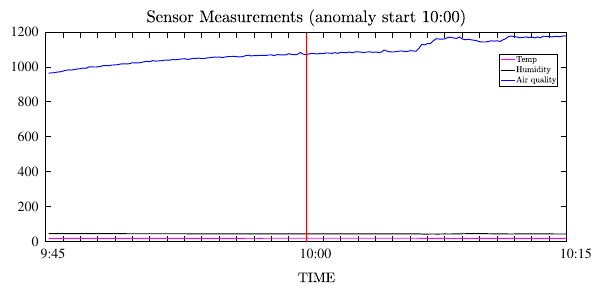
Fig. 1 An example for signal representation- Sensor